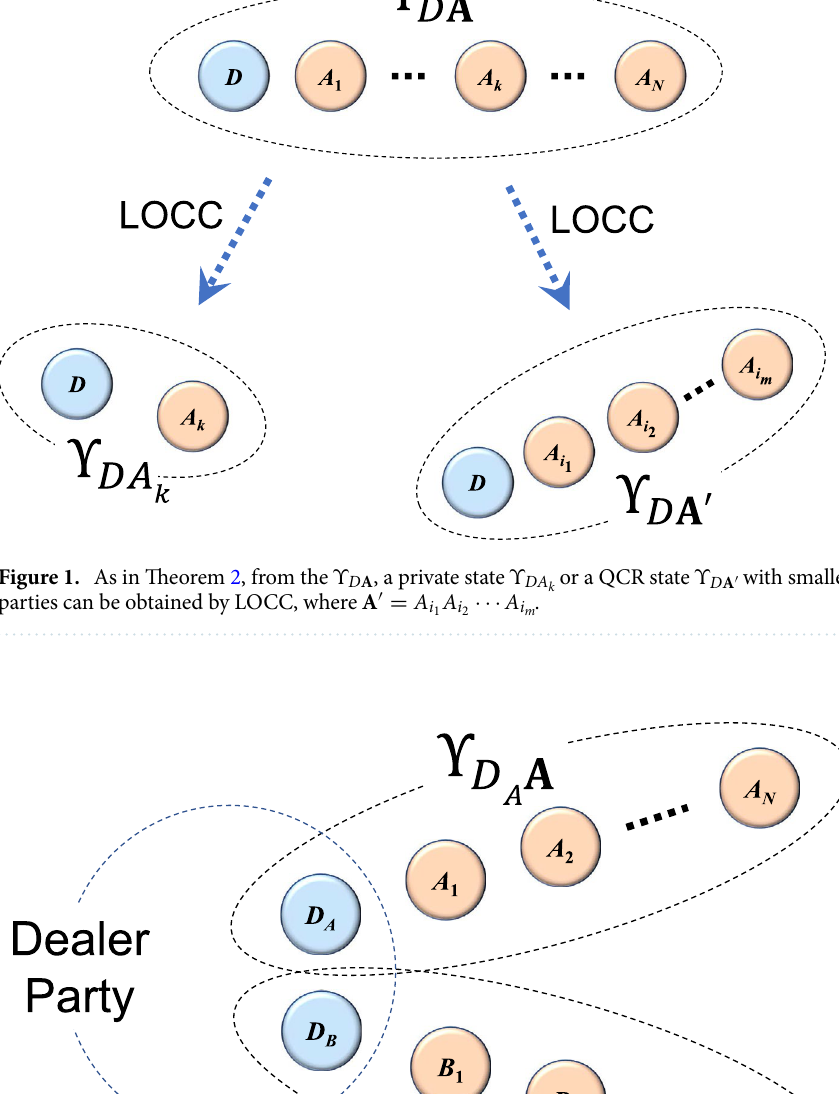
Figure 2. Constructing a QCR state with larger number of parties from two QCR states ϒ D A A and ϒ D B B in Theorem